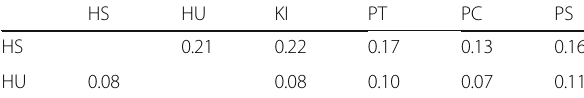
Table 5 Single class (SC) and multi-class (MC) AuC for SBU Kinect at σ = 0.1 0.11